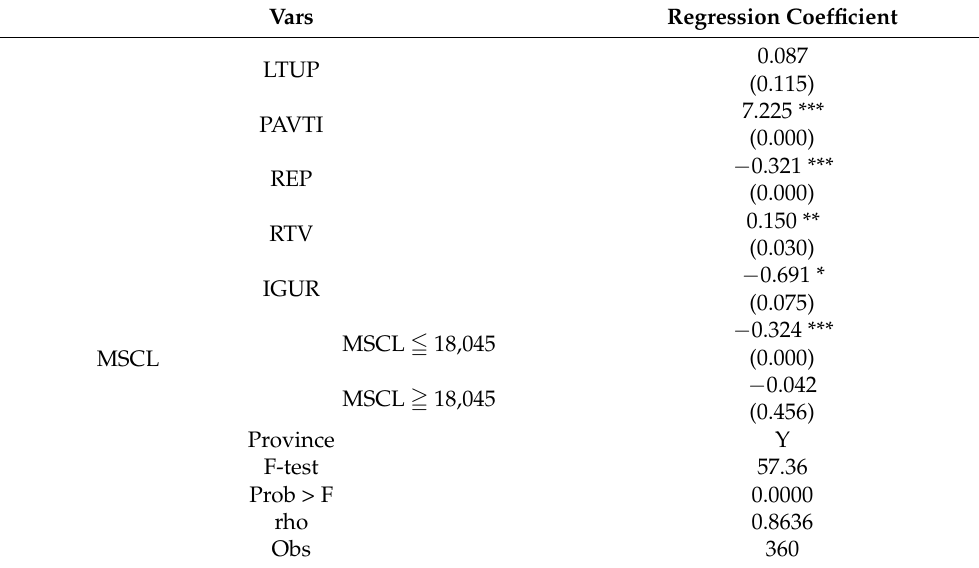
Table 5. Regression results of the threshold effect.